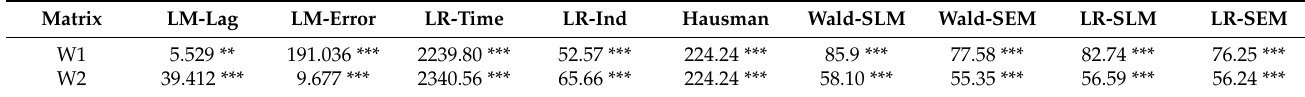
Table 7. Spatial econometric model